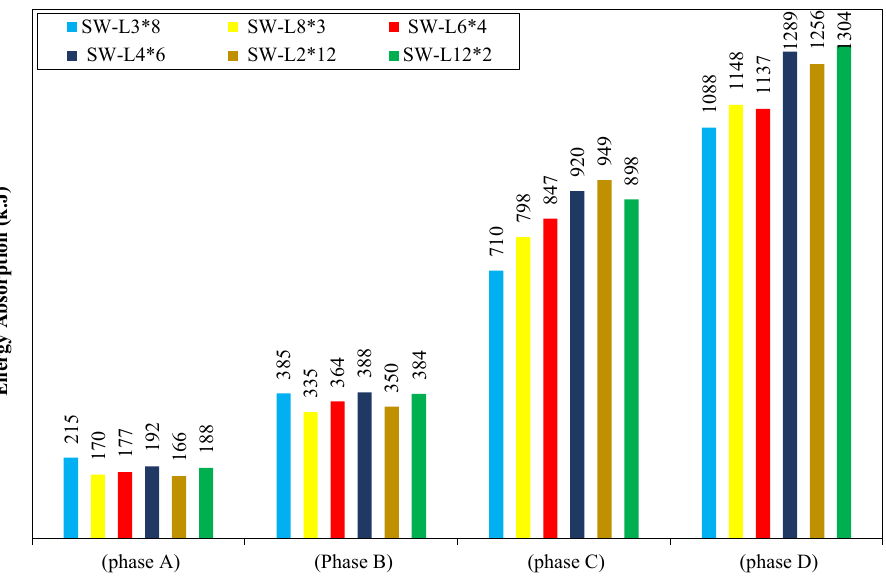
Figure 27 show the results of energy absorption of each model through each phase. For SW-L8*3, SW-L6*4, SW-L4*6, SW-L2*12 and SW-L12*2 in phase C, when changing the layout of the shear stud, the energy absorption increased (by 11.03, 16.17, 22.83, 25.18 and 20.94%) as compared with reference model SW-L3*8 (R). Through the phase D, it is noticed that change in the layout of the shear stud increased the energy absorption (by 5.23, 4.31, 15.59, 13.38 and 16.56%) for SW-L8*3, SW-L6*4, SW-L4*6, SW-L2*12 and SW-L12*2 as compared with reference model SW-L3*8 (R).